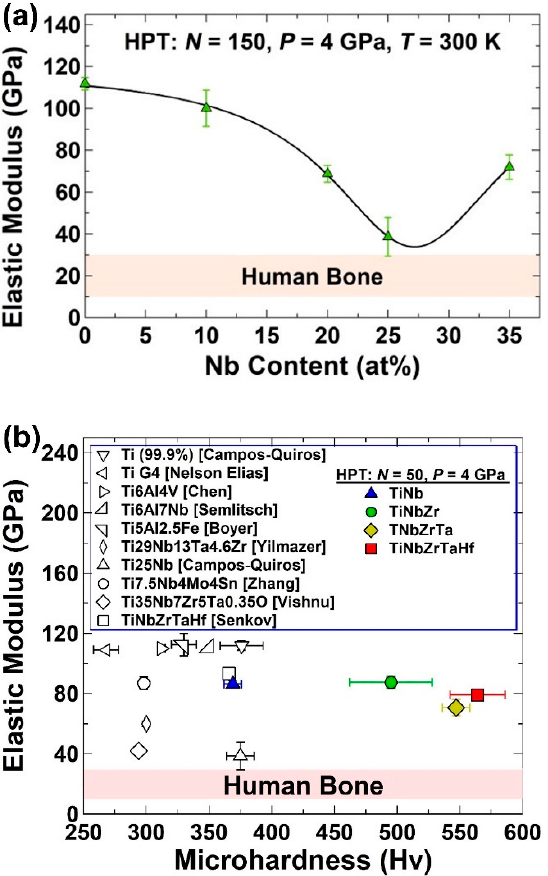
Figure 5. Low elastic modulus and high hardness of biocompatible alloys after ultra-SPD. ( a ) Elastic modulus versus Nb content in Ti-Nb biomaterial synthesized by ultra-SPD in comparison with elastic modulus of human bone [52]. ( b ) Elastic modulus versus microhardness for binary alloy TiNb, ternary alloy TiNbZr, medium-entropy alloy TiNbZrTa and high-entropy alloy TiNbZrTaHf synthesized by ultra-SPD in comparison with data reported for some alloys by other synthesis or SPD methods [57].